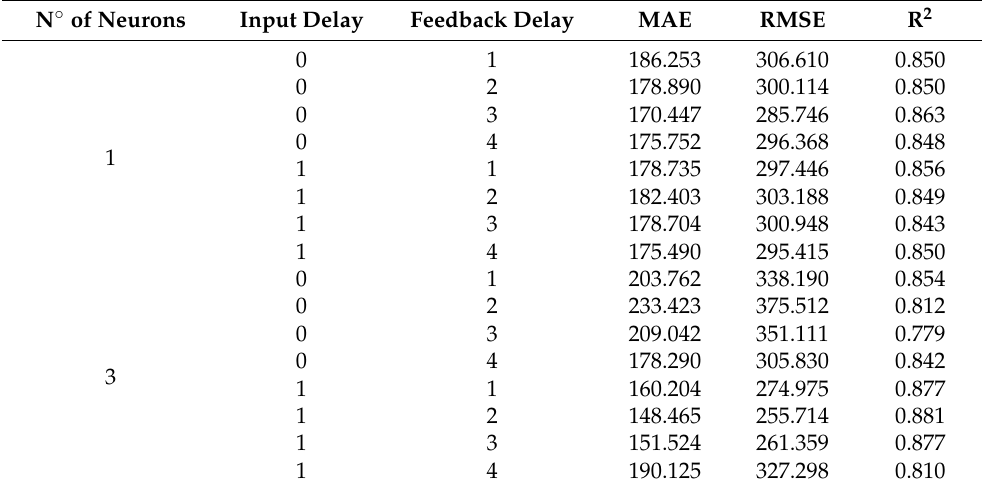
Table 3. Error results were obtained with the NARX model combining the different numbers of neurons and delays.